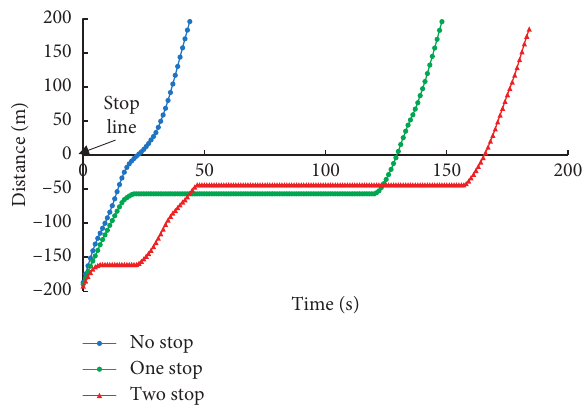
Figure 7: Three types of GPS trajectories at mixed-flow intersection. Table 1: Information of the eighty-five VSP